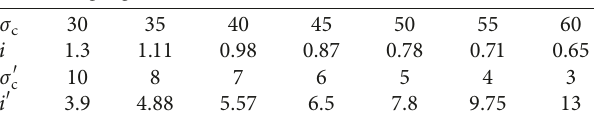
Table 1: Hard coal failure factor i and soft coal failure factor i ′ in hard coal